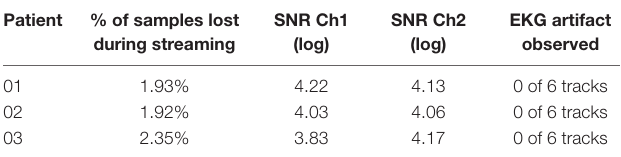
TABLE 1 | Details of data streaming in all patients.